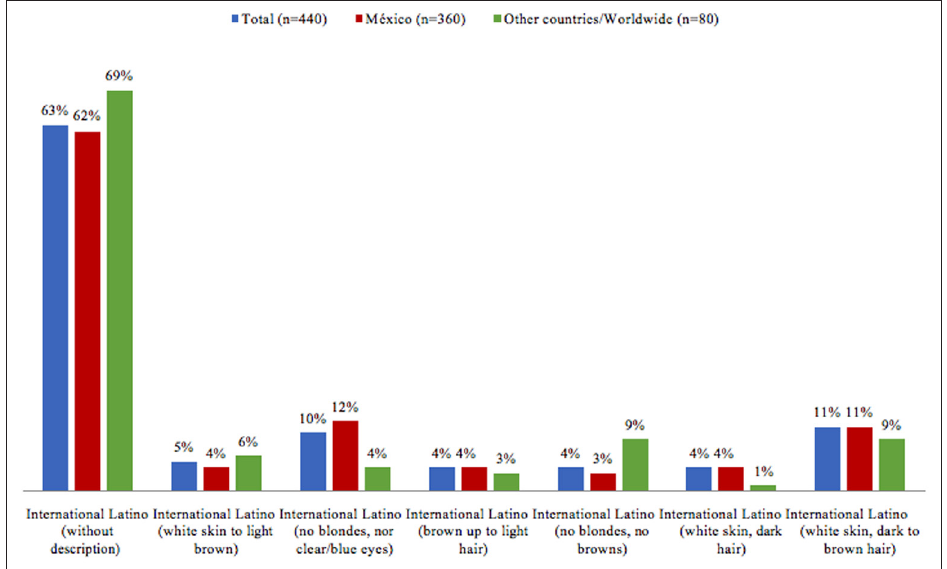
Figure 2: Phenotyping of ‘international Latino’ in advertising cast in Mexico. Source: Own